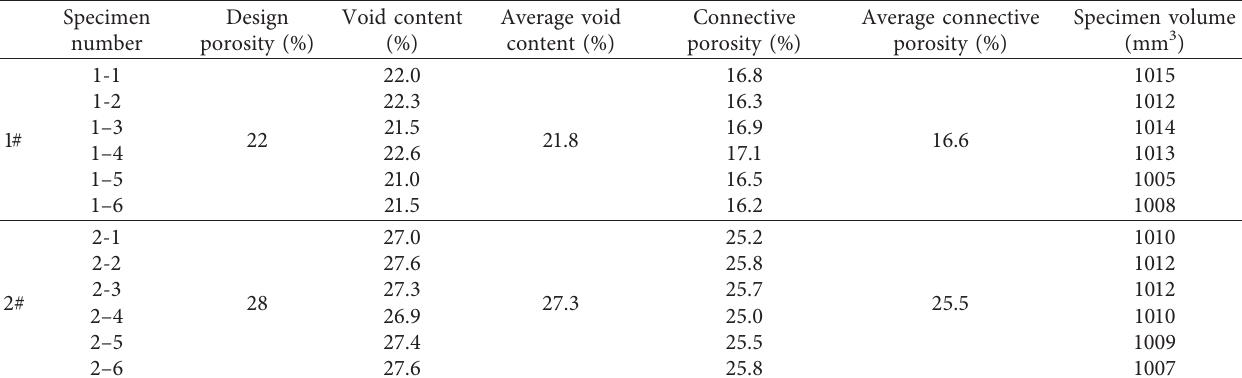
Table 4: Volume parameters of